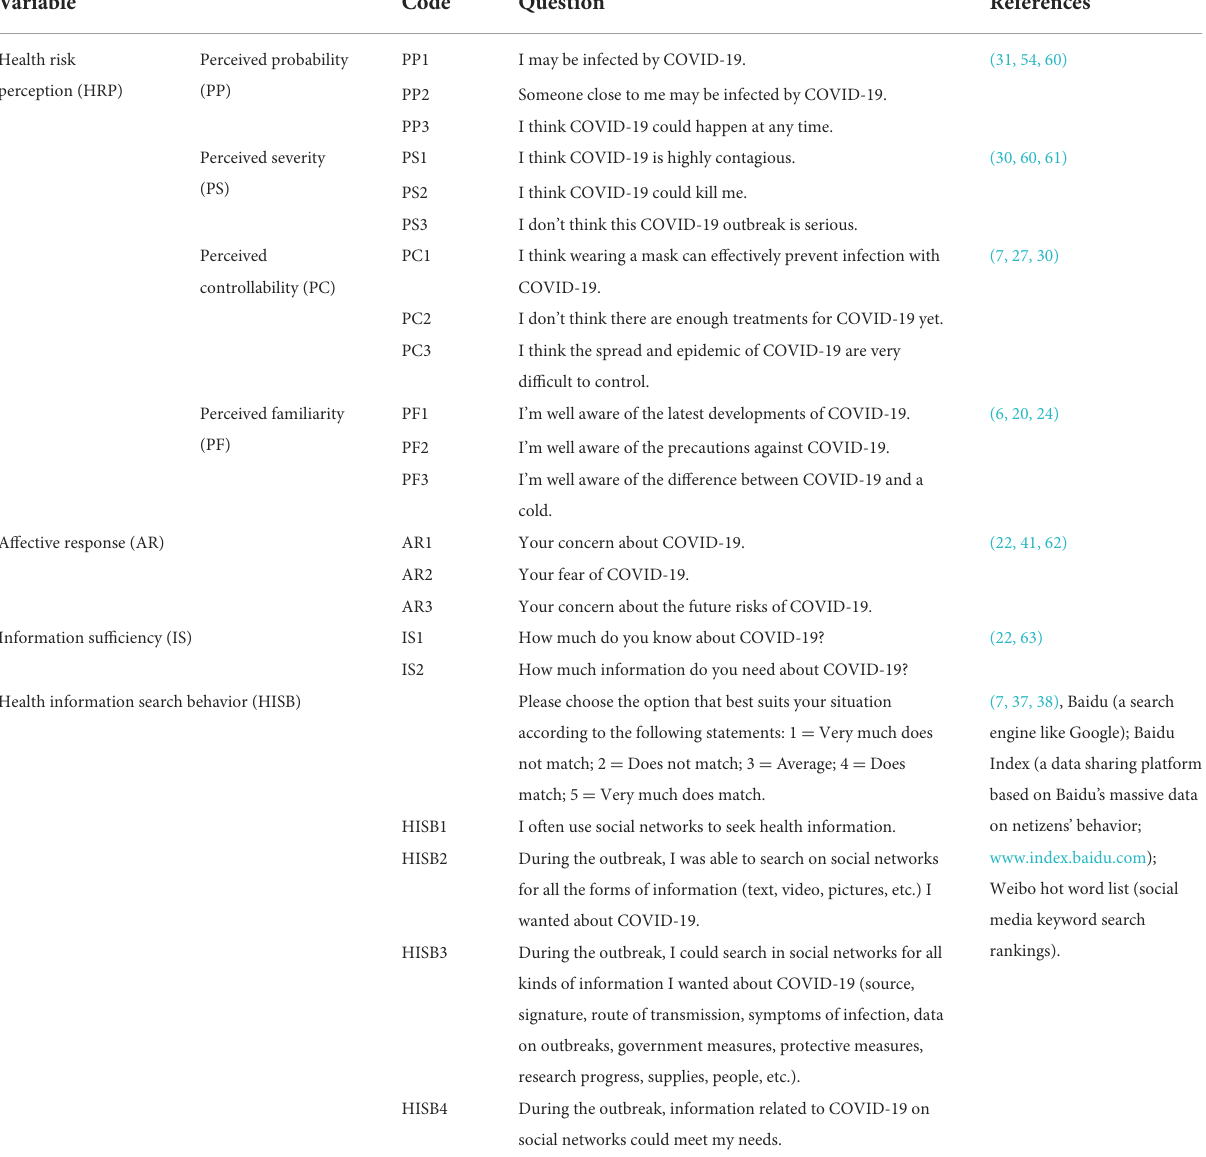
TABLE 2 The variables and